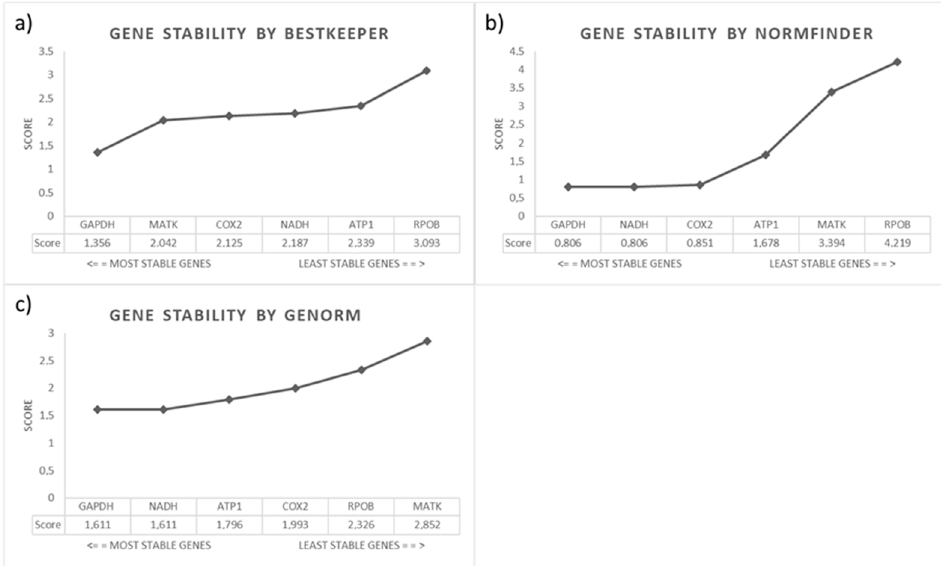
Figure 7. Graphs of gene stability analysis of ATP1, COX2, GAPDH, MATK, NADH and RPOB genes from blueberry plants treated with colchicine (1 day, 2 days, 3 days, 5 days and 30 days) using RefFinder software: (a) BestKeeper software results; (b) NormFinder software results; (c) GeNorm